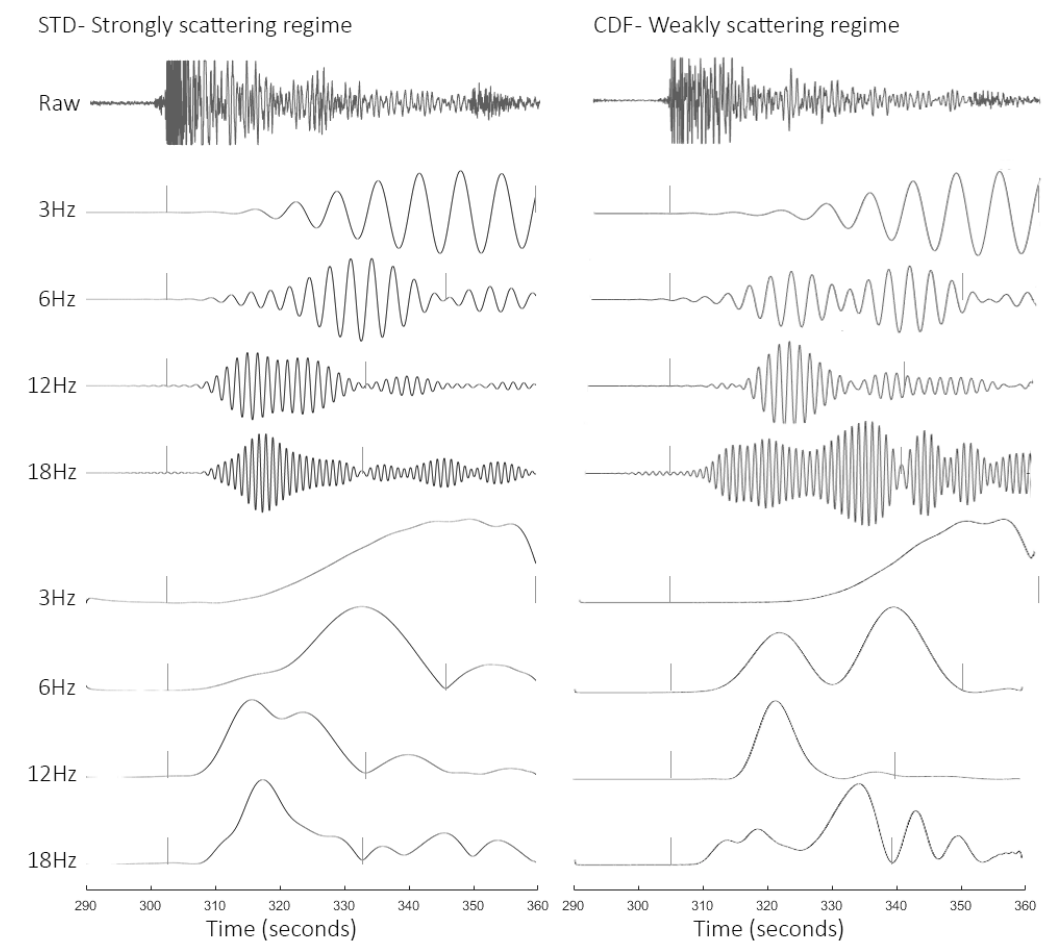
Figure 5. Z-component of an example seismic arrival at stations STD and CDF filtered at 3 Hz, 6 Hz, 12 Hz and 18 Hz. Calculated envelopes, from which energy density is measured, are plotted below with the analysis windows between t min and t max indicated as vertical bars. Note the reduction in t max as frequency increases.